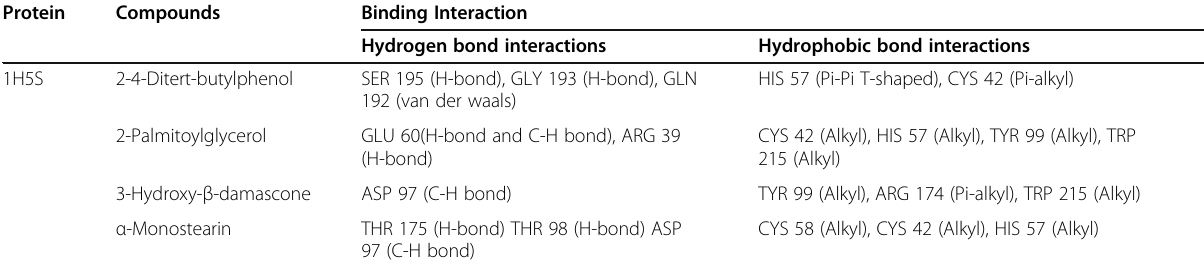
Table 4 Binding interactions of isolated compounds with the respective proteins for different biological activities (Continued) Protein